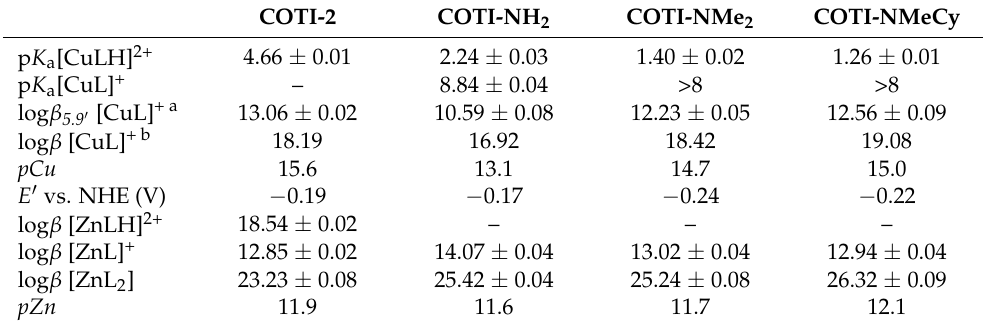
measurements: c L = c Cu(II) = 1 mM, pH = 7.40 (10 mM HEPES), T = 25 ◦ C, I = 0.1 M tetrabutylammonium nitrate, 90% ( v/v ) DMSO/H 2 O, and 0.01 V/s scan rate. a Determined by an EDTA competition study by UV-vis